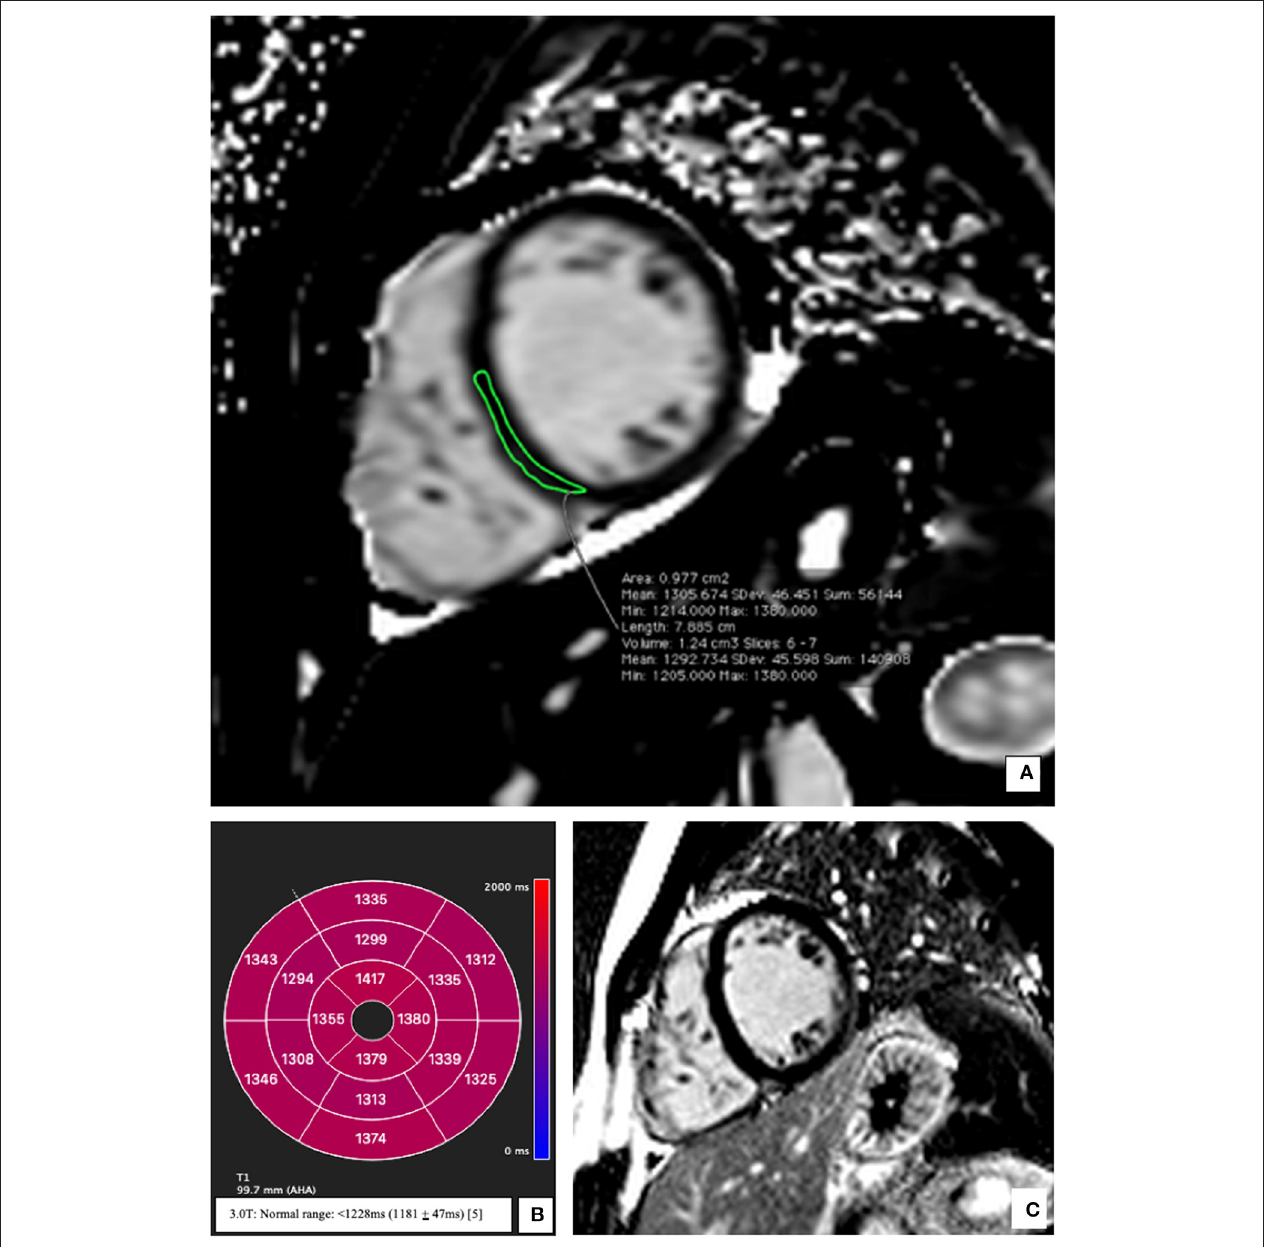
FIGURE 2 | Representative native T1 mapping image and the corresponding late gadolinium enhancement (LGE) image at presentation. (A) Midventricular short axis image of T1 map (SAX) showing elevation of the T1 times; an example from the inferoseptal segment (demarcated green area: 1,305ms). (B) Bullseye plot showing the native T1-times. Segmentation was performed according to the AHA 16-segment model. Native T1 times were increased in all segments irrespective of the presence/absence of LGE. (C) Corresponding mid-ventricular SAX LGE image without evidence of LGE. Normal T1 Mapping values for a 3 Tesla MRI < 1,228ms (1,181 ± 47ms)